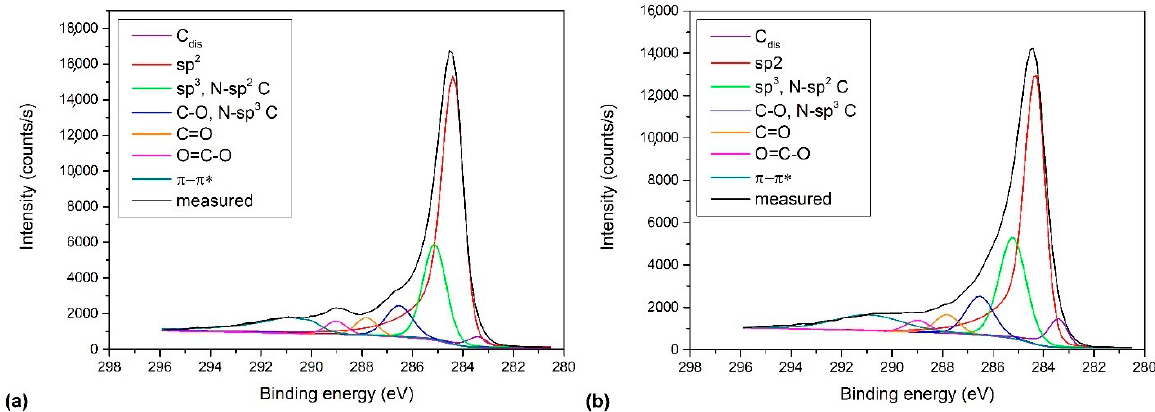
Figure 9. Selected C1s spectra of as-deposited N-doped carbon nanomesh samples. The deposition times were: ( a ) 30 s, and ( b ) 120 s.